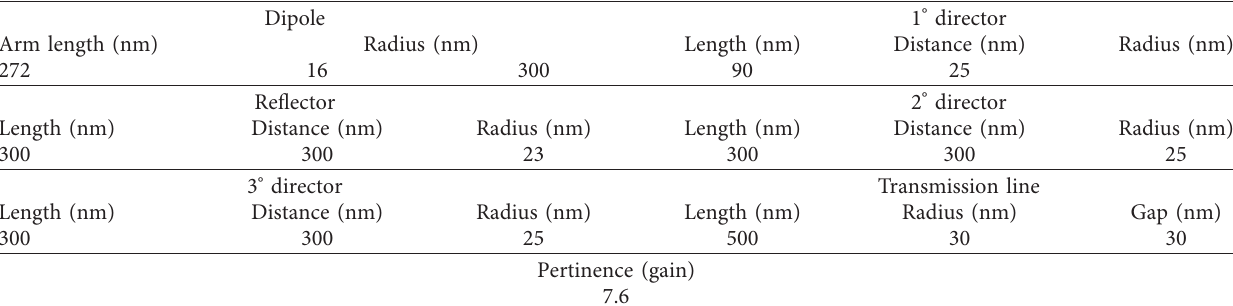
Length (nm) Distance (nm)